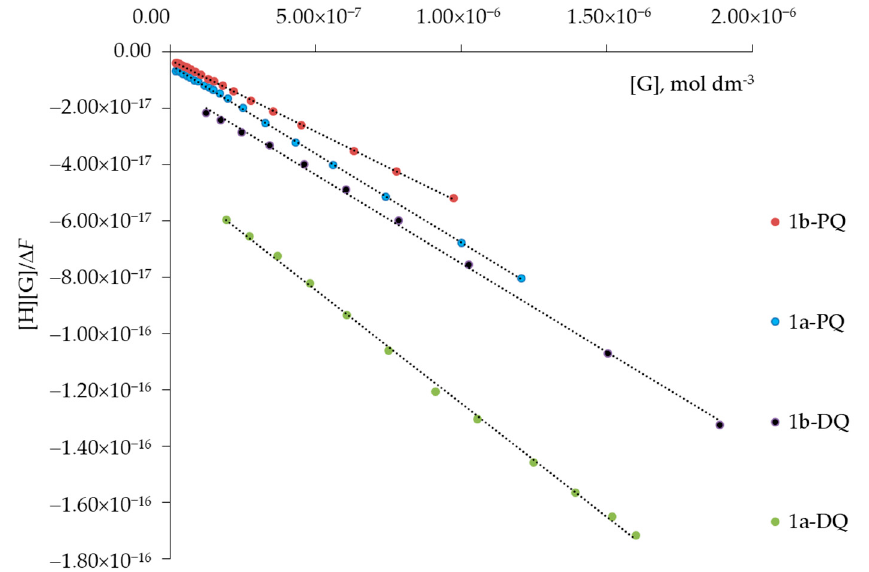
Figure 7. Typical plot of [H][G]/ ∆ F versus [G], mol dm − 3 for the complexation of host 1a (or 1b) with the guest (G), paraquat (PQ) or diquat (DQ). The dashed lines represent the fitted function by using Equation (1).